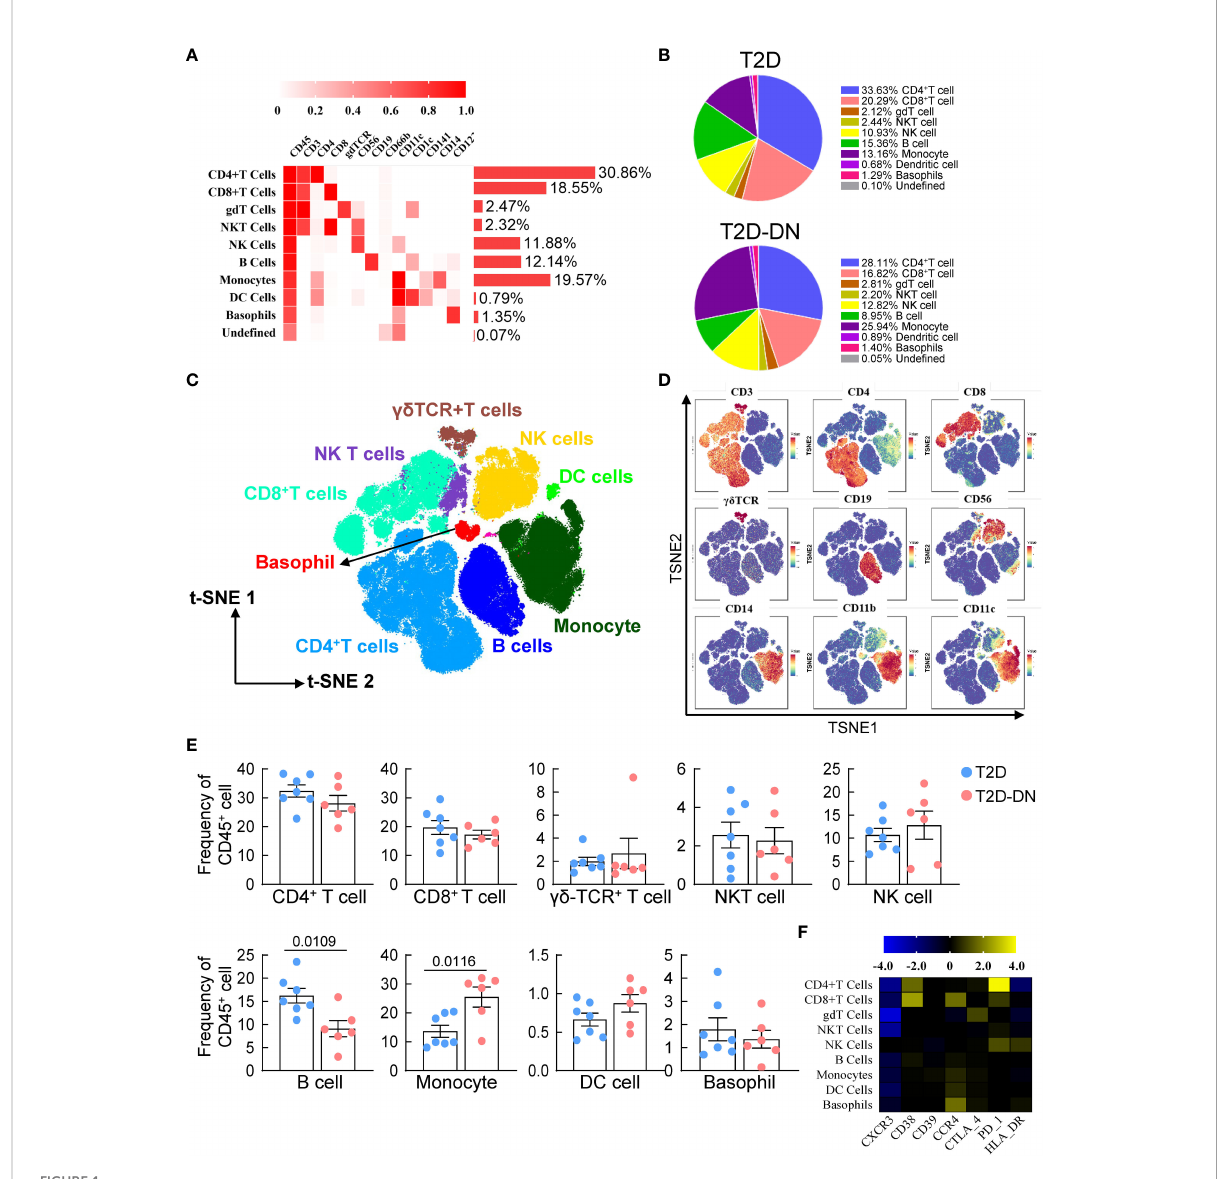
FIGURE 1 Peripheral immunity signature traits in the early-stage diabetic nephropathy patients. (A) Heatmap analysis for the overall proportions of major immune cell subsets in diabetic nephropathy (B) Pie chart characterizing the differences of major immune cell subsets proportions between T2D-DN and T2D patients. (C) Distributions of major immune cell subsets (D) The key immune cell markers for immune cell subsets are analyzed by t-SNE algorithm. (E) Statistical frequency differences of immune cell subsets between T2D-DN and T2D patients. (F) Heatmap analysis for the expressions of functional immune cell markers in the measurable immune cell subsets. Data are expressed as means ± SEM, n = 6 in T2D-DN group and n = 7 in T2D